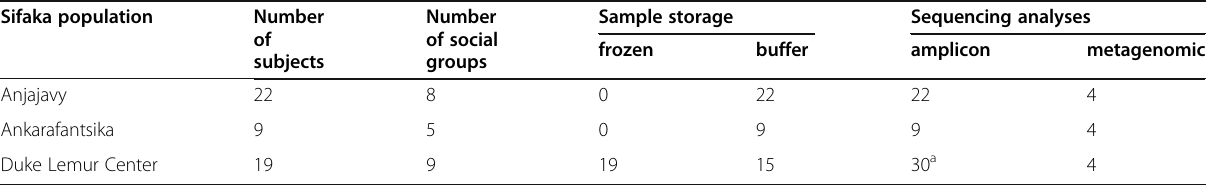
Table 1 Study subjects, sample sizes, and methods used Sifaka